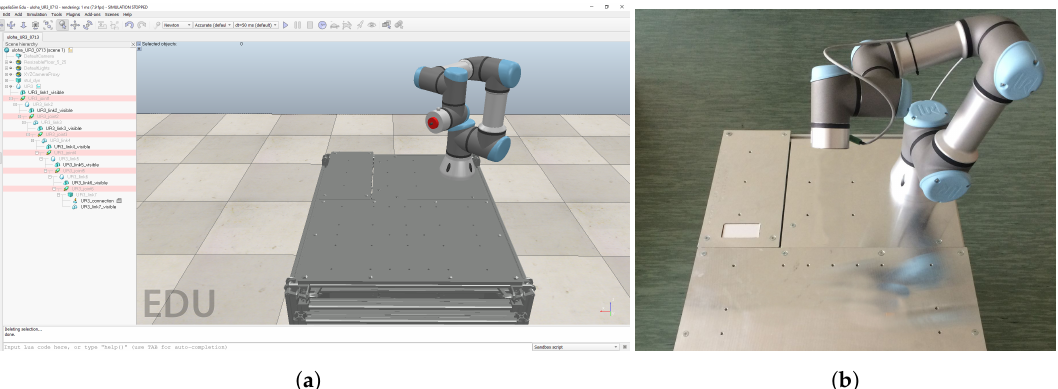
Figure 5. Experimental measurement setup: ( a ) Simulation environment in CoppeliaSim, ( b ) UR3 robot mounted to the